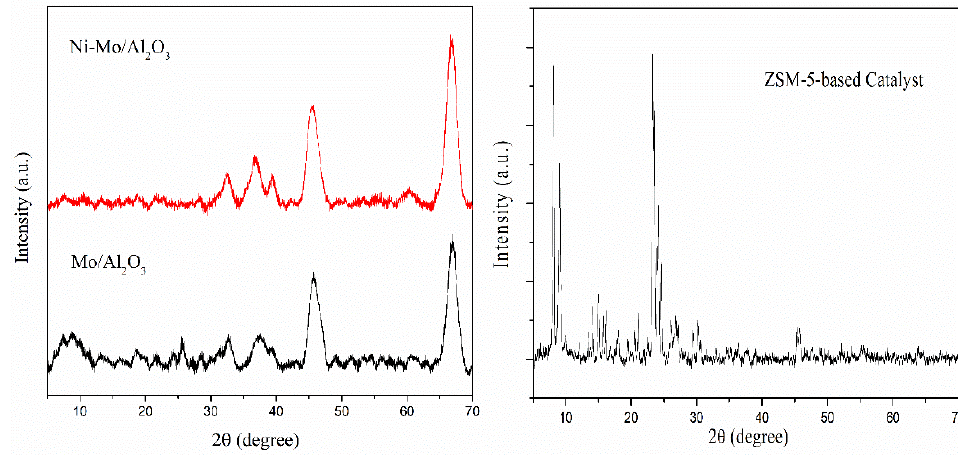
Figure 1. XRD patterns of Mo/Al 2 O 3 , Ni-Mo/Al 2 O 3 , and the ZSM-5-based catalyst.